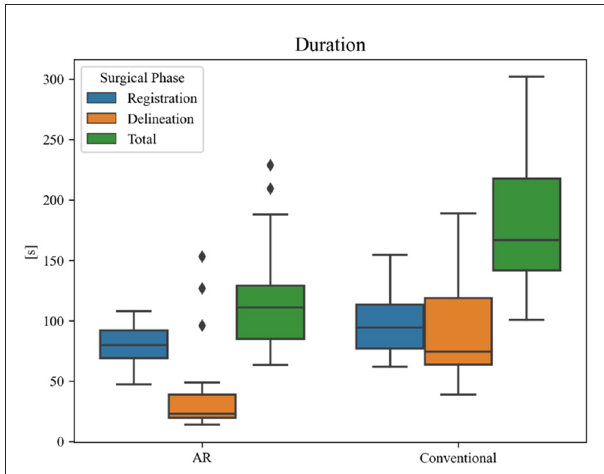
FIGURE12 Duration of surgical planning phases for each technique. The black diamonds represent outlier data.